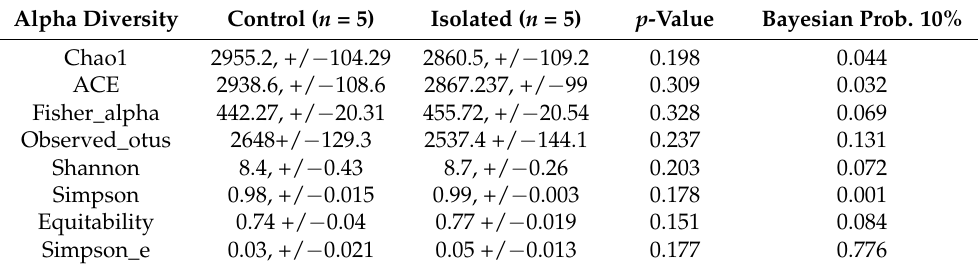
Table 6. Summary of estimated alpha diversity indices in the sheep hindgut microbiome from the two experimental groups. p -values for among-group differences from analysis of variance ( p -value) and Bayesian results (Bayesian probability 10%). The column Bayesian 10% reports the probability, estimated from a Bayesian model, that the difference between the two groups is larger than the threshold (see M&M).